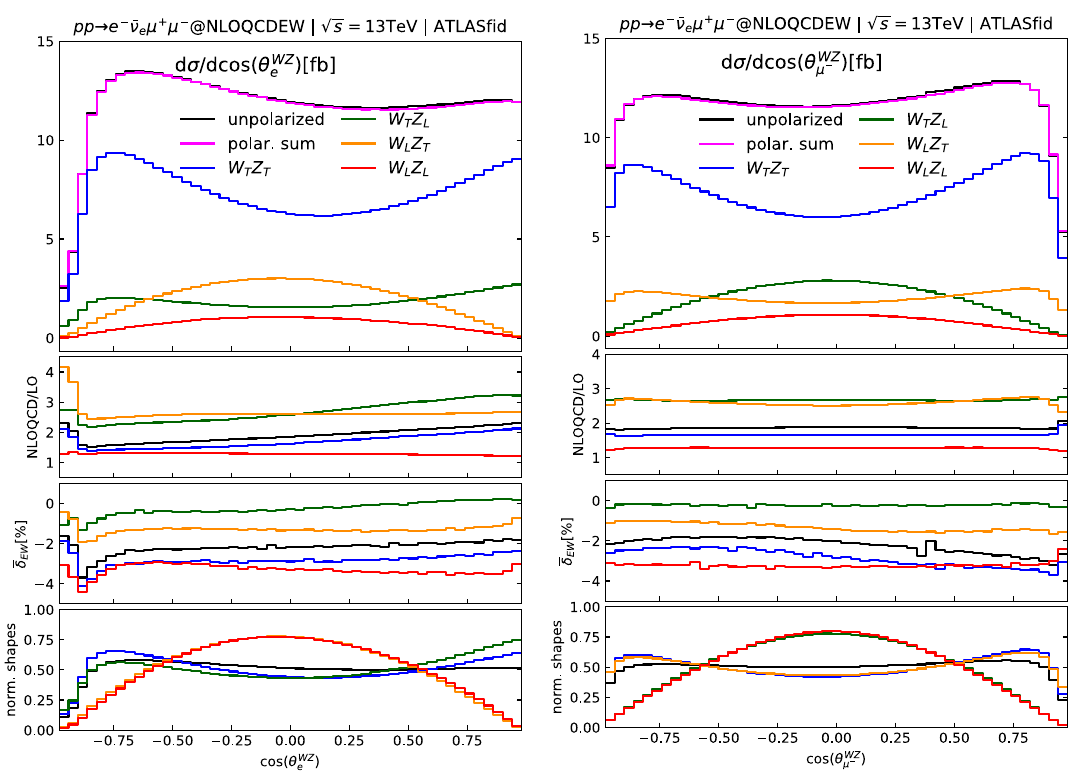
Fig. 2 Distributions in cos θ WZ e (left) and cos θ WZ μ − (right). These anglesarecalculatedinthe W Z center-of-masssystem(moredetailsare provided in the text), hence denoted with the W Z superscript. The big panelshowstheabsolutevaluesofthecrosssectionsatNLOQCD+EW.